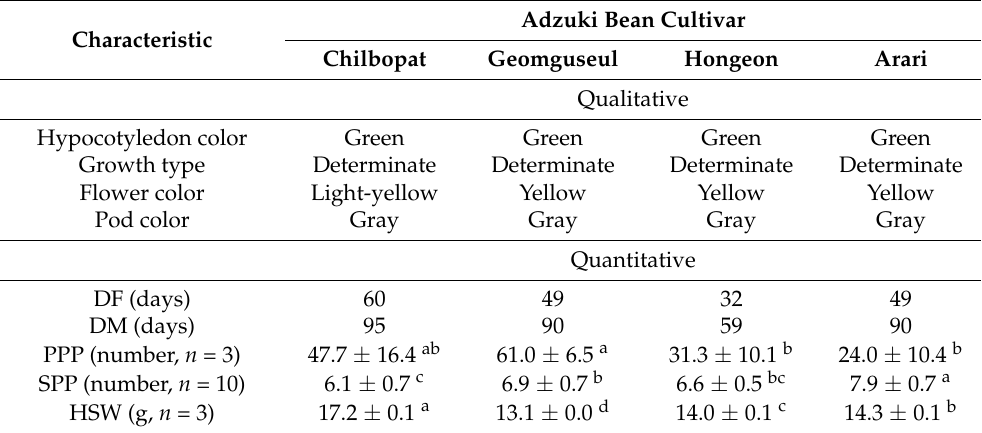
Table 1. Key agronomical characteristics of four adzuki bean cultivars cultivated in